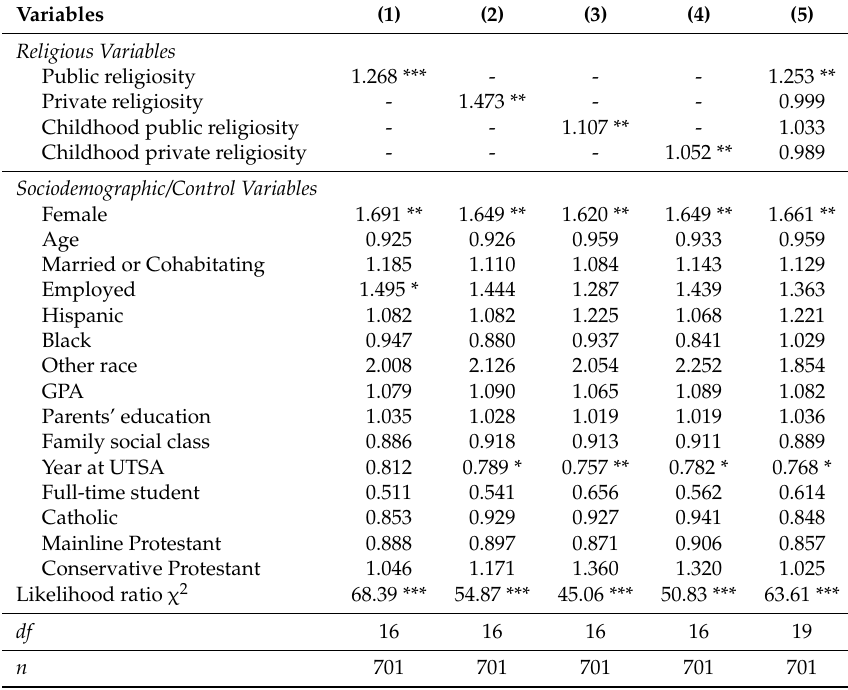
Table 2. Binary logistic regression models predicting odds of past year secular volunteerism.